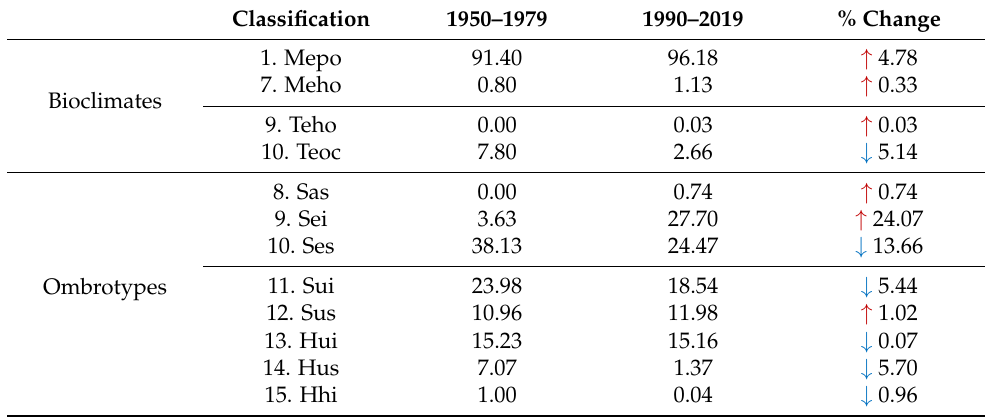
Table 6. Percentage of the territory (in %) for each bioclimate, ombrotype, and thermotype classifi- cation for mainland Portugal, for the periods 1950–1979 and 1990–2019.